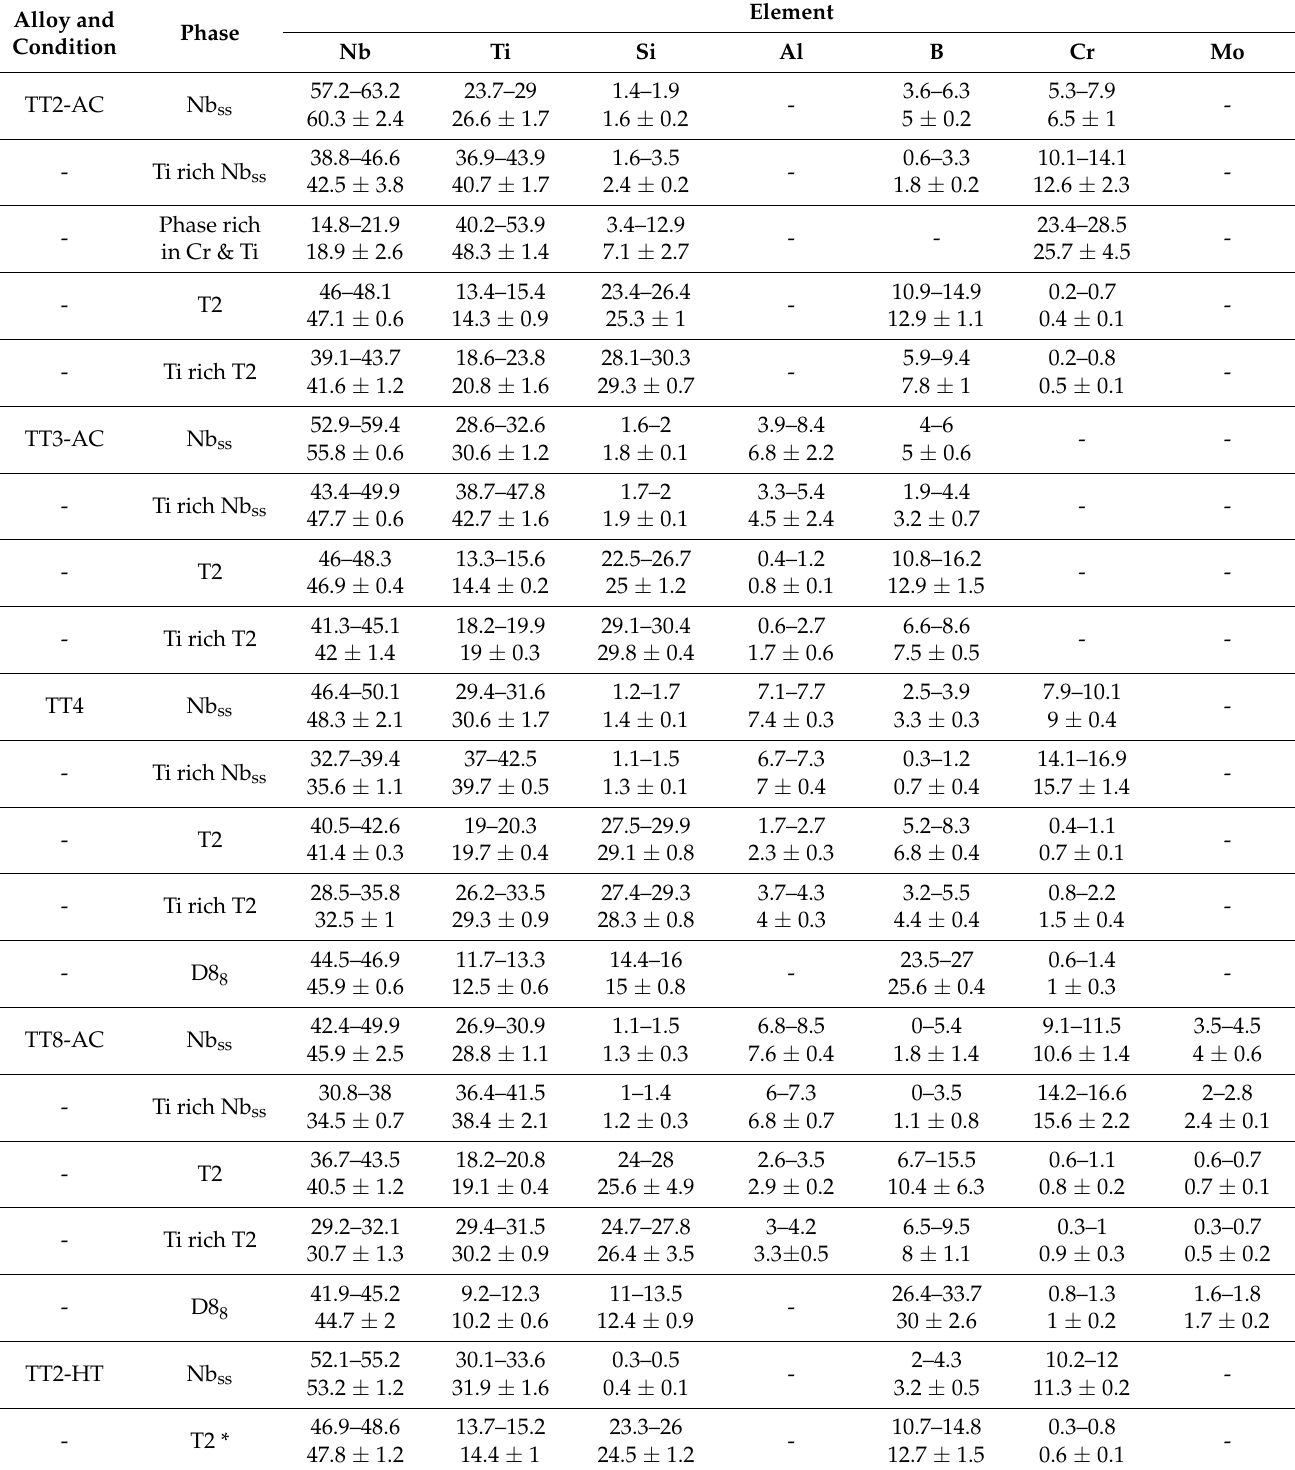
Table 5. EPMA data for the chemical composition (at.%) of phases in AC and HT